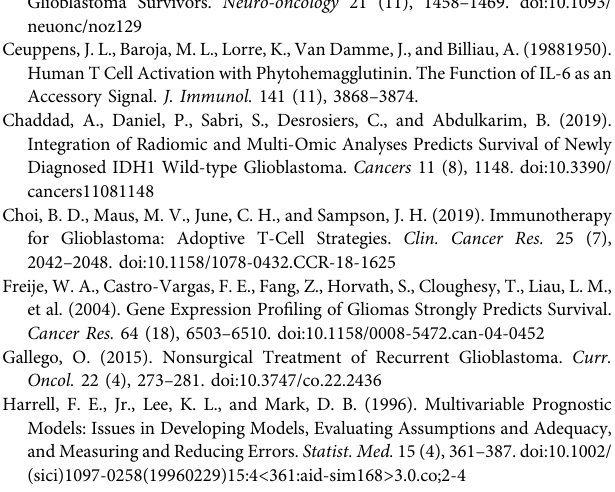
Supplementary Figure 1 | Lowess results. (A) . mRNAsi with OS in TCGA. (B) . c_mRNAsiwithOSinTCGA. (C) .mRNAsiwithOSinCGGA. (D) .c_mRNAsiwithOS in CGGA. Supplementary Figure 2 | Identi fi cation of optimal cut-off values. (A) . Optimal cut- off value of mRNAsi in TCGA. (B) . Optimal cut-off value of c_mRNAsi in TCGA. (C) . Optimal cut-off value of mRNAsi in CGGA. (D) . Optimal cut-off value of c_mRNAsi in CGGA. Supplementary Figure 3 | Survival curve of mRNAsi/c_mRNAsi on prognosis. (A) . Disease-speci fi c survival curve of mRNAsi in TCGA. (B) . Disease-speci fi c survival curve of c_mRNAsi in TCGA. (C) . Progression-free interval curve of mRNAsi in TCGA. (D) . Progression-free interval curve of c_mRNAsi in TCGA. Supplementary Figure 4 | External validation in CGGA and GEO. (A) . AUC in TCGA. (B) . C-index in CGGA. (C) . Prediction error in CGGA. (D) . 0.5-year DCA in CGGA. (E) . 1-year DCA in CGGA. (F) . 1.5-year DCA in CGGA. (G) . 3-year DCA in CGGA. (H) . 5-year DCA in CGGA. (I) . 0.5-year calibration in CGGA. (J). 1-year calibration in CGGA. (K) . 1.5-year calibration in CGGA. (L) . 3-year calibration in CGGA. (M) . 5-year calibration in CGGA. (N) . AUC in GSE4412. (O) . AUC in GSE13041. Supplementary Figure 5 | Construction of prognostic